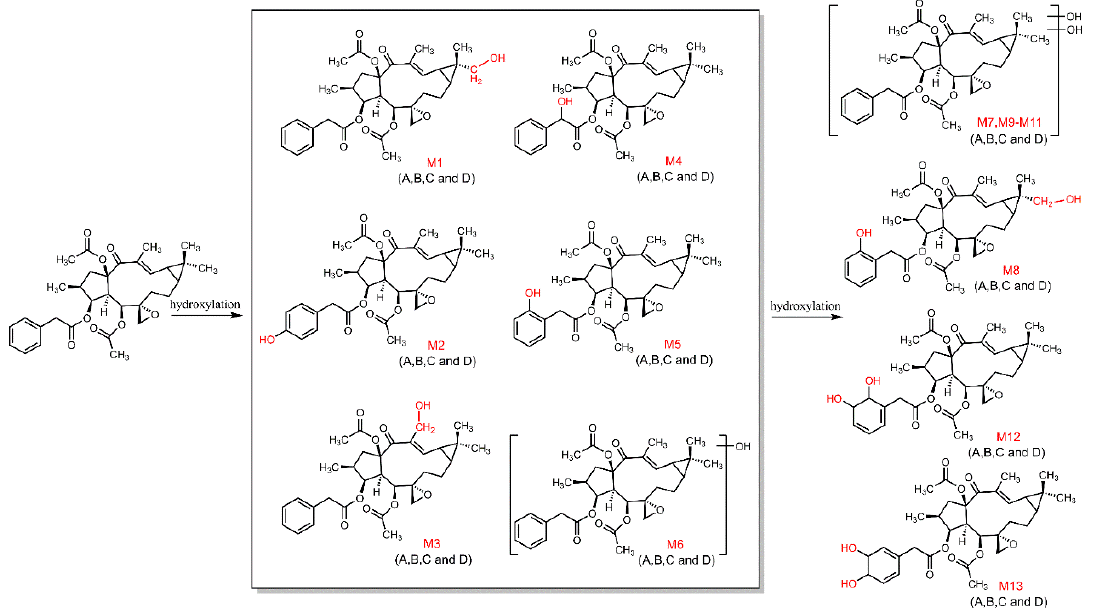
Figure 9. The proposed metabolic pathway of euphorbiasteroid in rats (I).